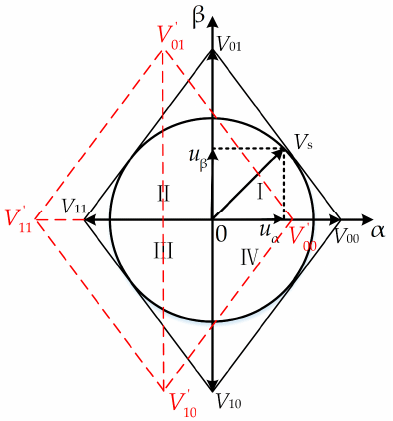
Figure 2. Distribution of voltage vectors under capacitor voltage offset. In the figure, the red dashed line shows the distribution of the basic voltage